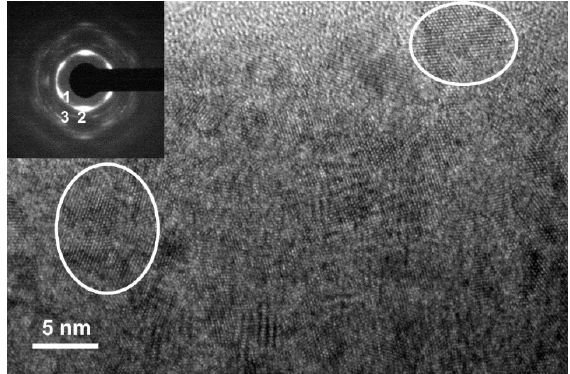
Figure 5. Cross-section high-resolution transmission electron microscopy (HRTEM) image of the 7% N 2 film (inset is the selected-area electron diffraction (SAED) pattern).